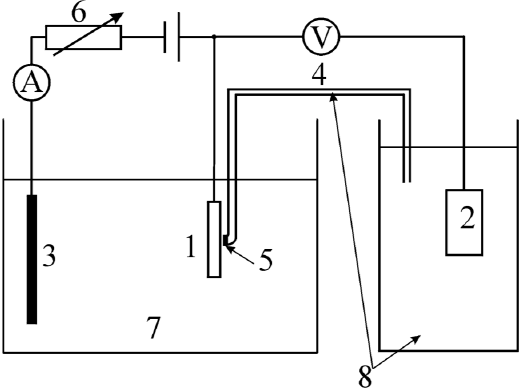
Figure 4. Three electrode system: 1—working electrode; 2—reference electrode; 3—auxiliary electrode; 4—salt bridge; 5—semipermeable membrane; 6—adjustable voltage source; 7—electrolyte; 8—solution of own ions of reference